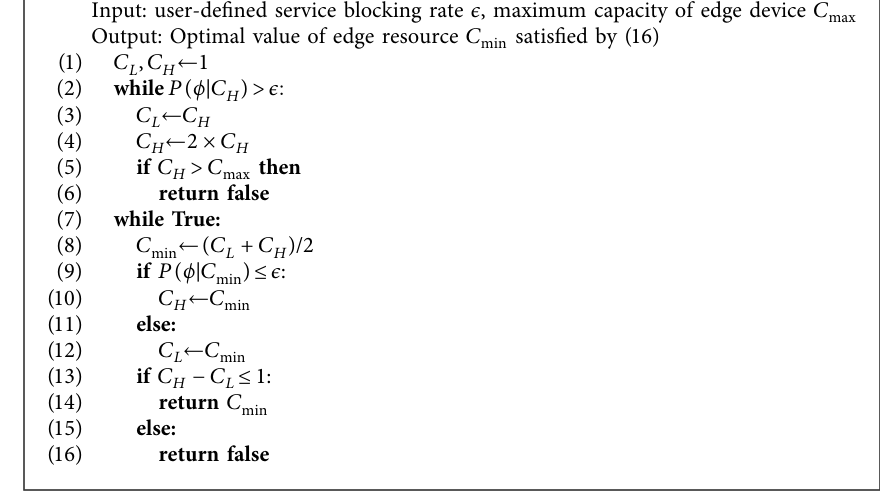
A LGORITHM 1: Two-stage algorithm.